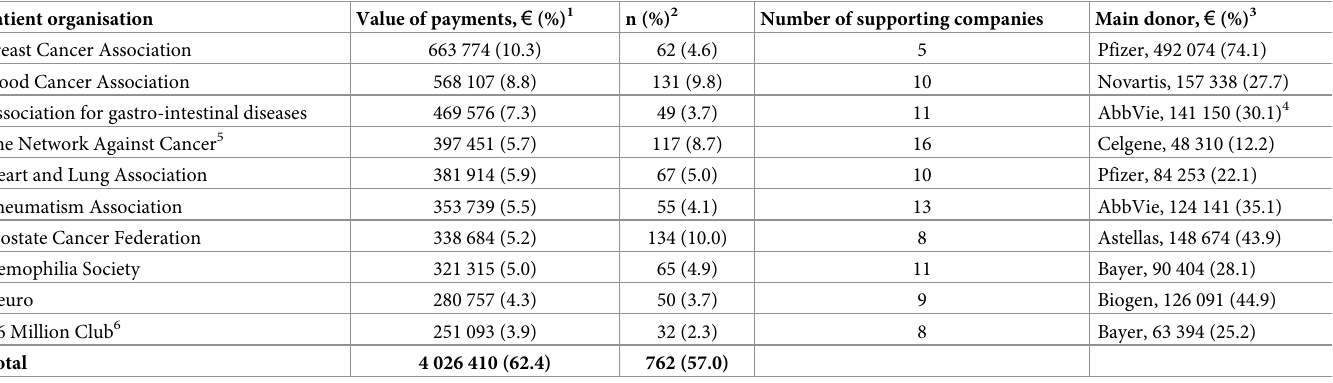
Table 3. Ten most funded patient organisations by reporting drug companies in Sweden